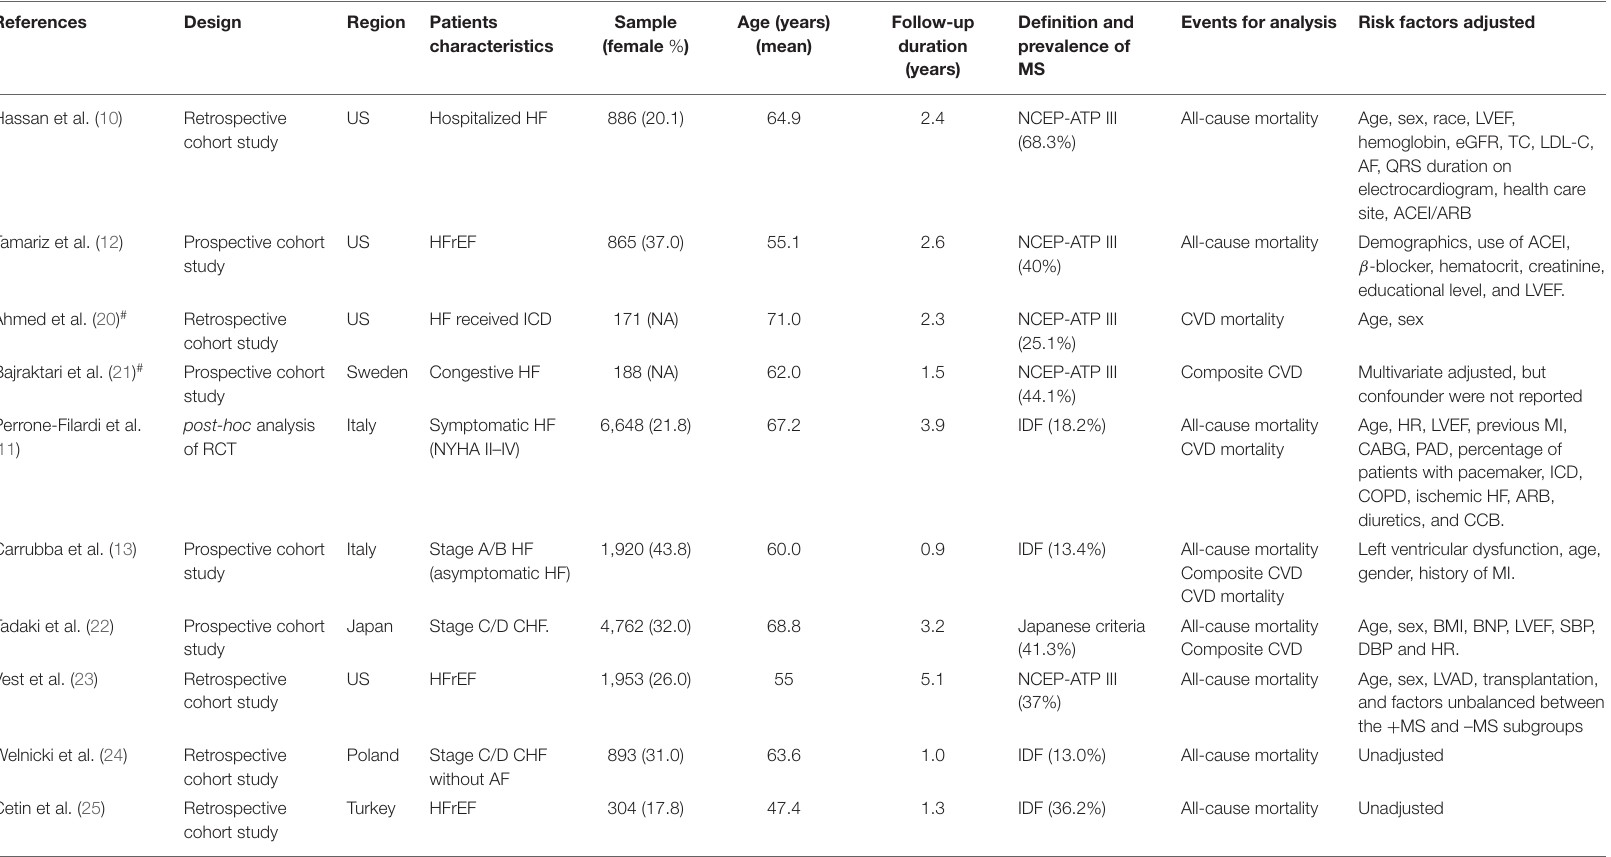
TABLE 1 | Characteristics of the included